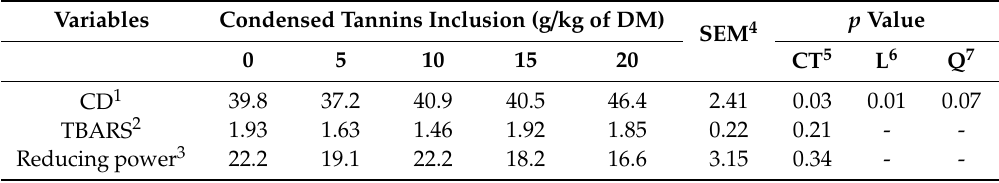
Table 8. Oxidative profile of milk from Holstein cows fed diets with five levels of condensed tannins from Acacia